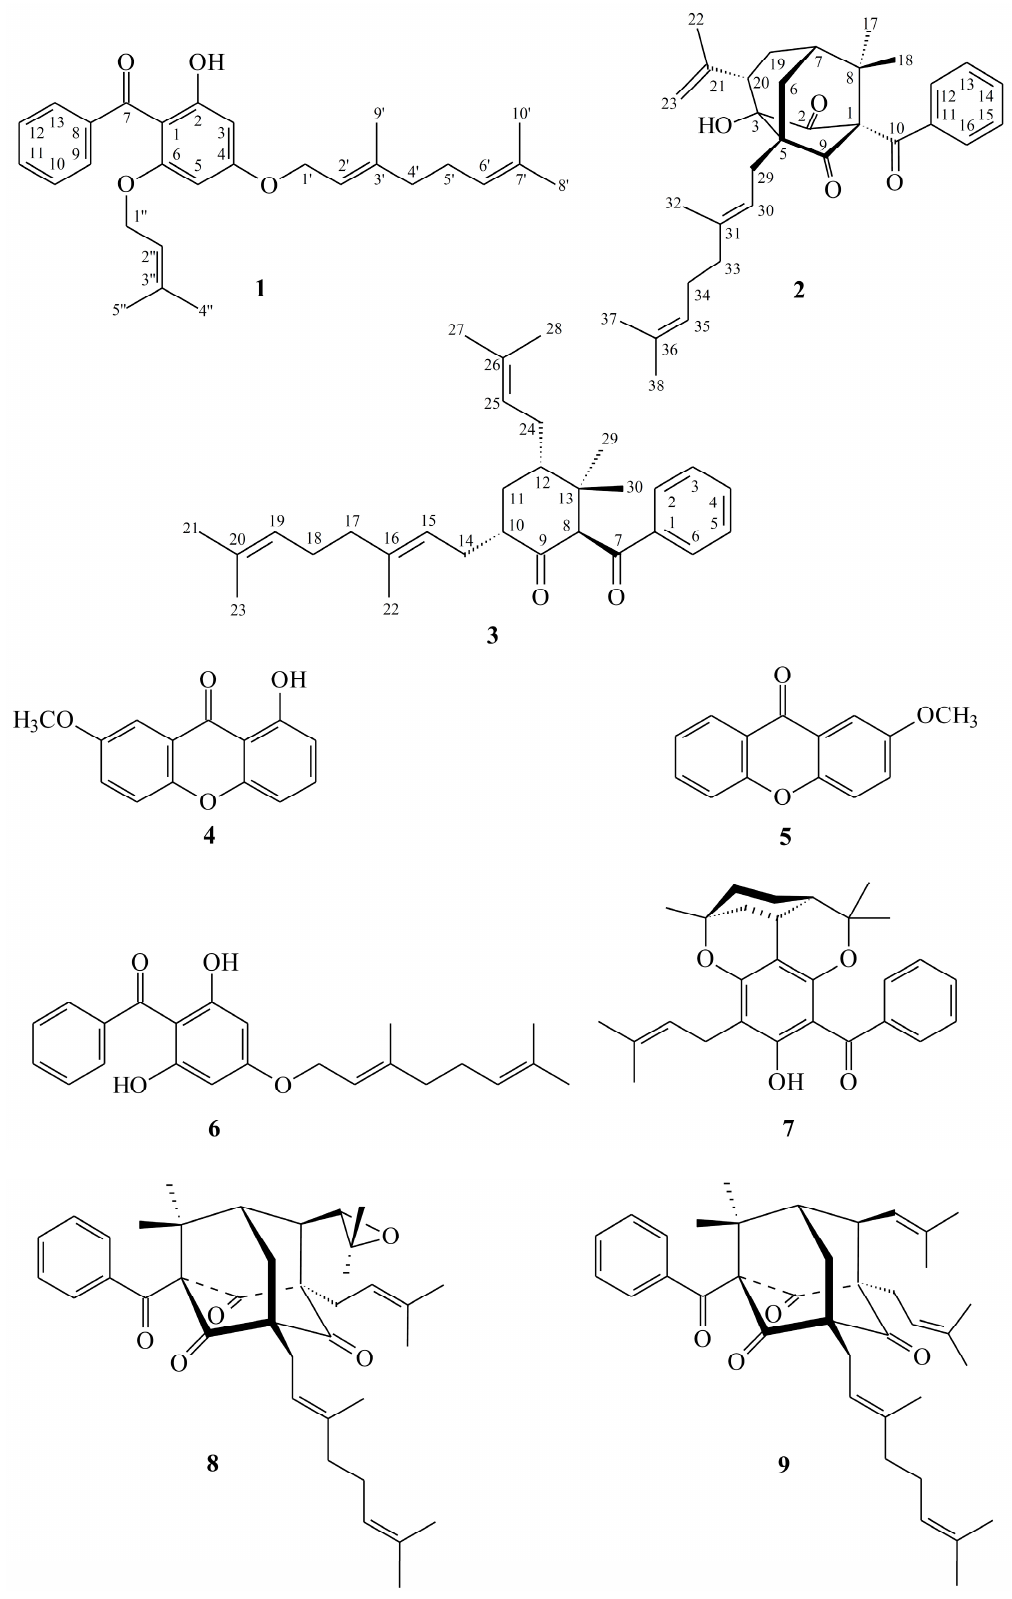
Figure 2. Chemical structures of Compounds 1 – 9 isolated from H. sampsonii